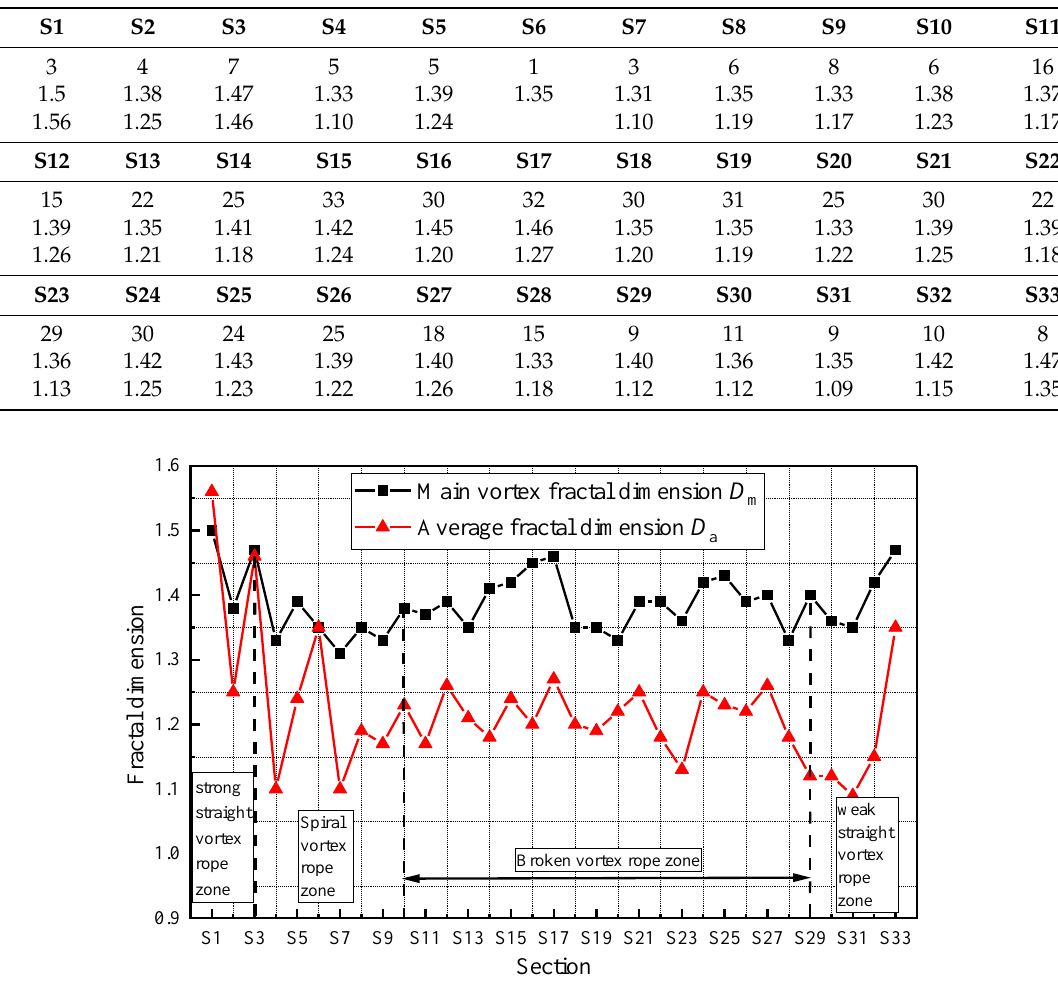
Table 3. Main vortex fractal dimension ( D m ) or average fractal dimension ( D a ) of vortex rope on each section.